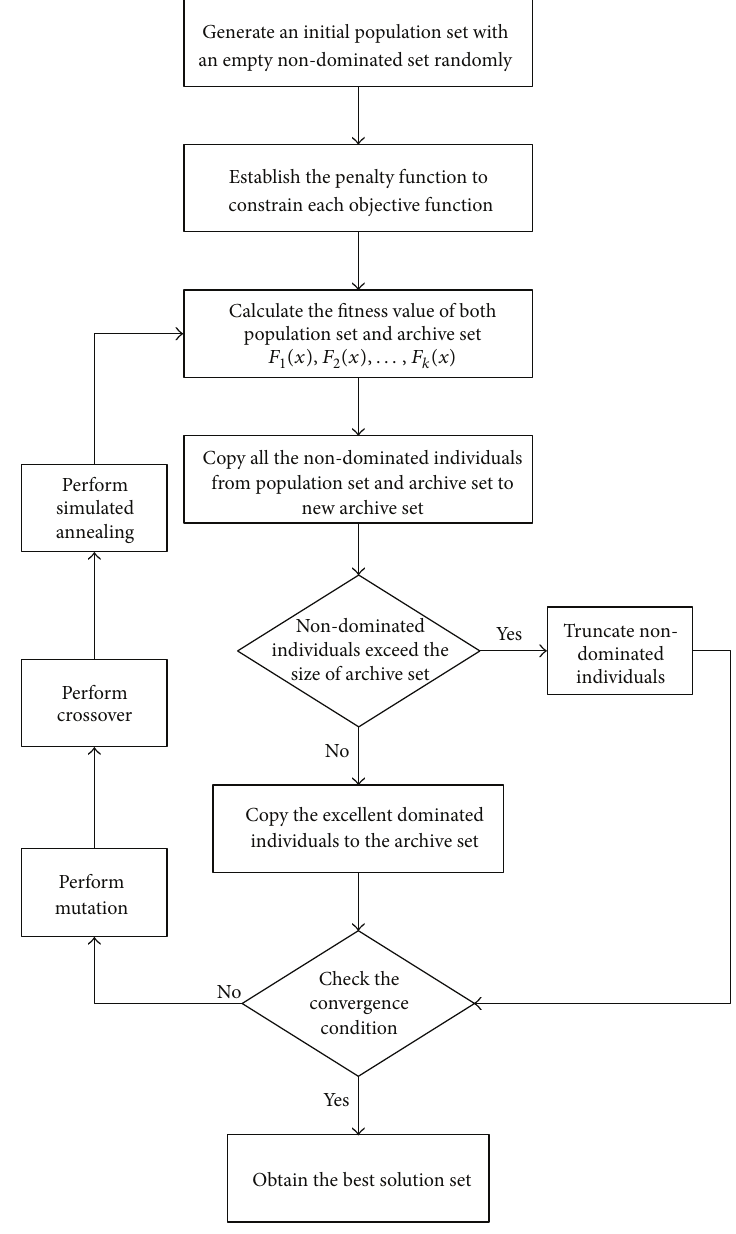
Figure 2: Flowchart of improved Pareto-based evolutionary